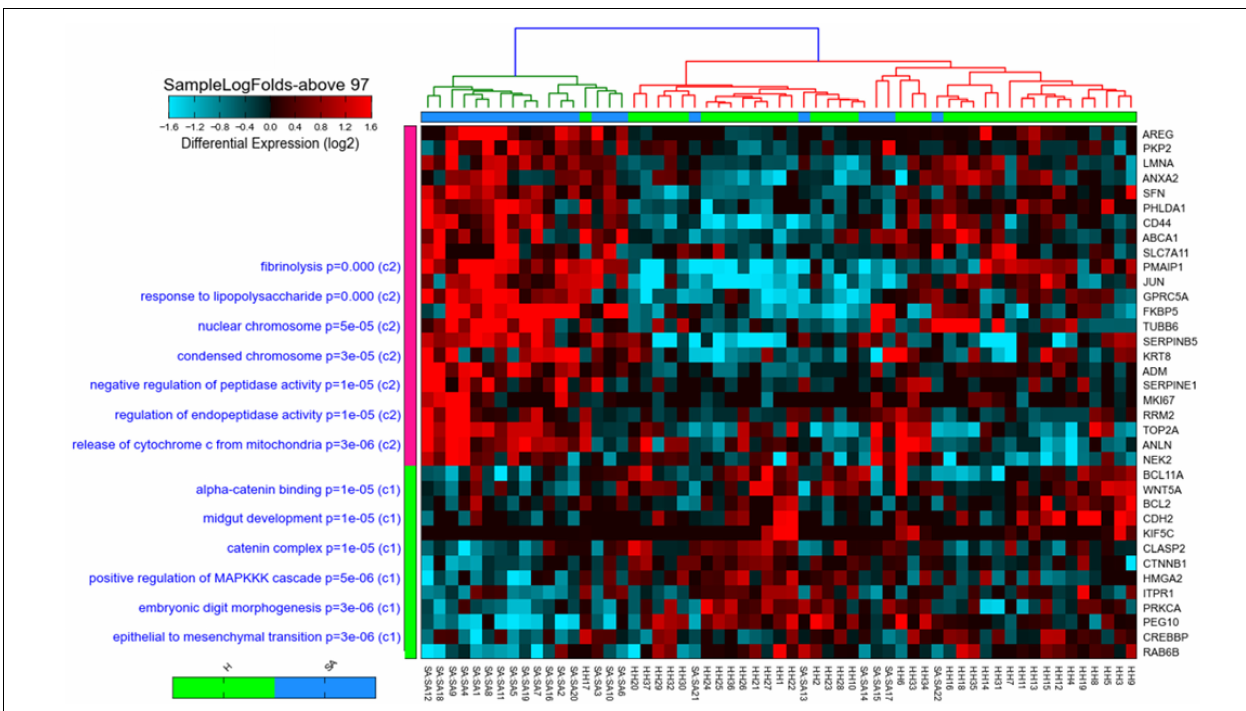
FIGURE 2 | Heat map and cosine hierarchical clustering using the expression of the 35-gene signature of samples in the GSE64913 dataset comparing healthy controls (H) to severe asthmatics (SAepithelial brushings obtained from severe asthma patients ( N = 17) and healthy volunteers ( N = 23). The 35 genes that show a statistically significant differential expression in severe asthmatics compared to healthy are shown on the right panel, while pathways where those genes are enriched significantly are shown on the left panel of the plot. Samples were clustered using Cosine hierarchical clustering. The graph was generated using AltAnalyze software.